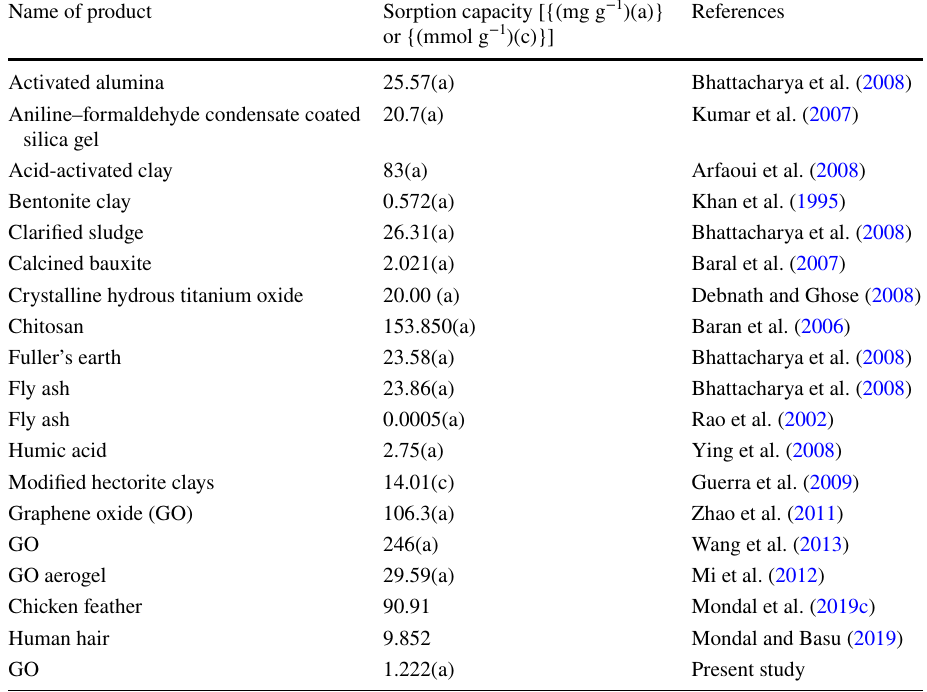
Table 4 Adsorption capacity of various